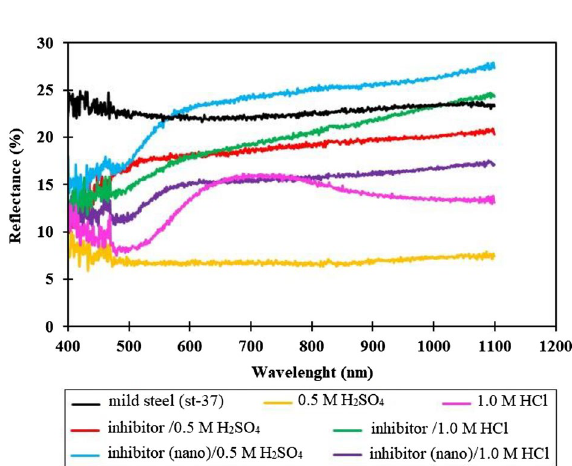
Figure 10. UV-Vis spectrum for st-37 specimens in 0.5 M H 2 SO 4 , and 1.0 M HCl solutions in the absence, and presence of an optimum concentration of Dracocephalum extract as a corrosion